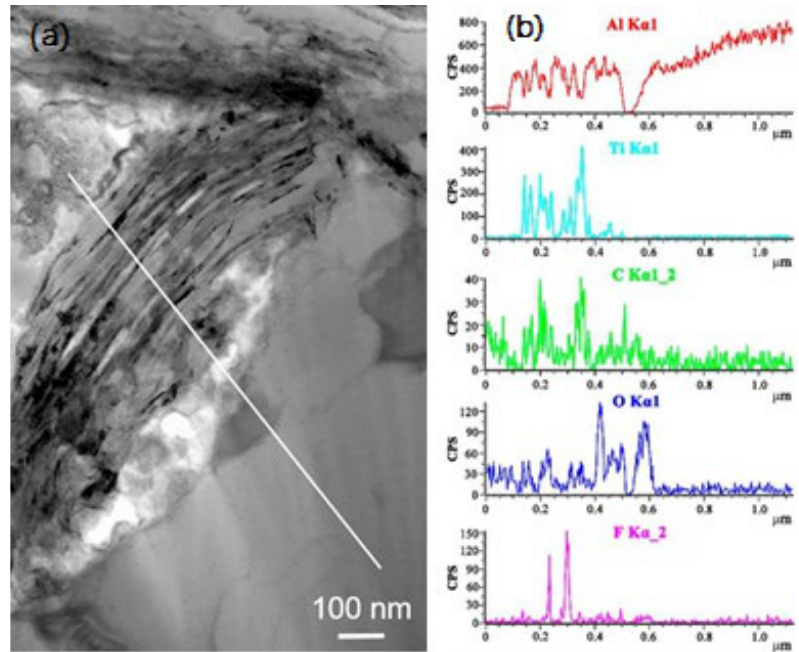
Figure 19. TEM image ( a ) and EDS results of Ti 3 C 2 T x /Al sample sintered at 650 °C ( b ). The EDS scan analysis along the line in ( a ) showing the elemental distribution of Al, Ti, C, O, and F. Reprinted with permission from [71]. Copyright 2018 materials MDPI.